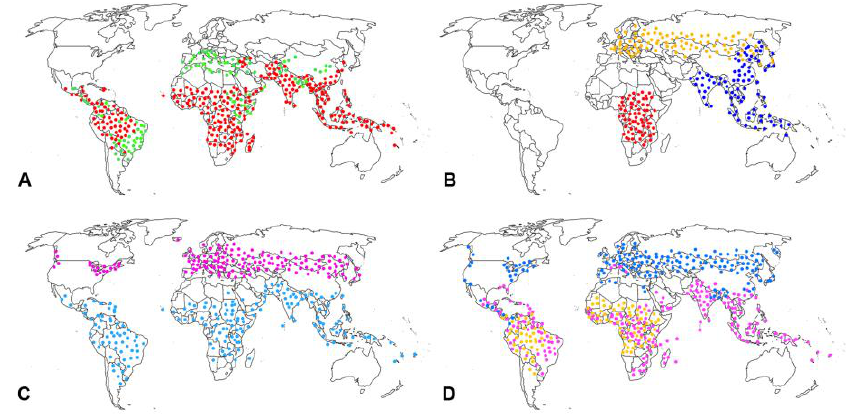
Figure 2. Geographical distribution of some of the most frequent infectious diseases to be considered in feverish children returning from international travels. Dots outline the area of geographical distribution of the disease; they do not indicate single locations or relative incidence ( A ) Red: malaria. Green: visceral leishmaniasis. ( B ) Red: African trypanosomiasis. Yellow: tick-borne encephalitits. Blue: Japanese encephalitis. ( C ) Blue: dengue. Violet: Lyme’s disease. ( D ) Blue: babesiosis. Yellow: yellow fever. Violet: chikungunya (data from [123]).